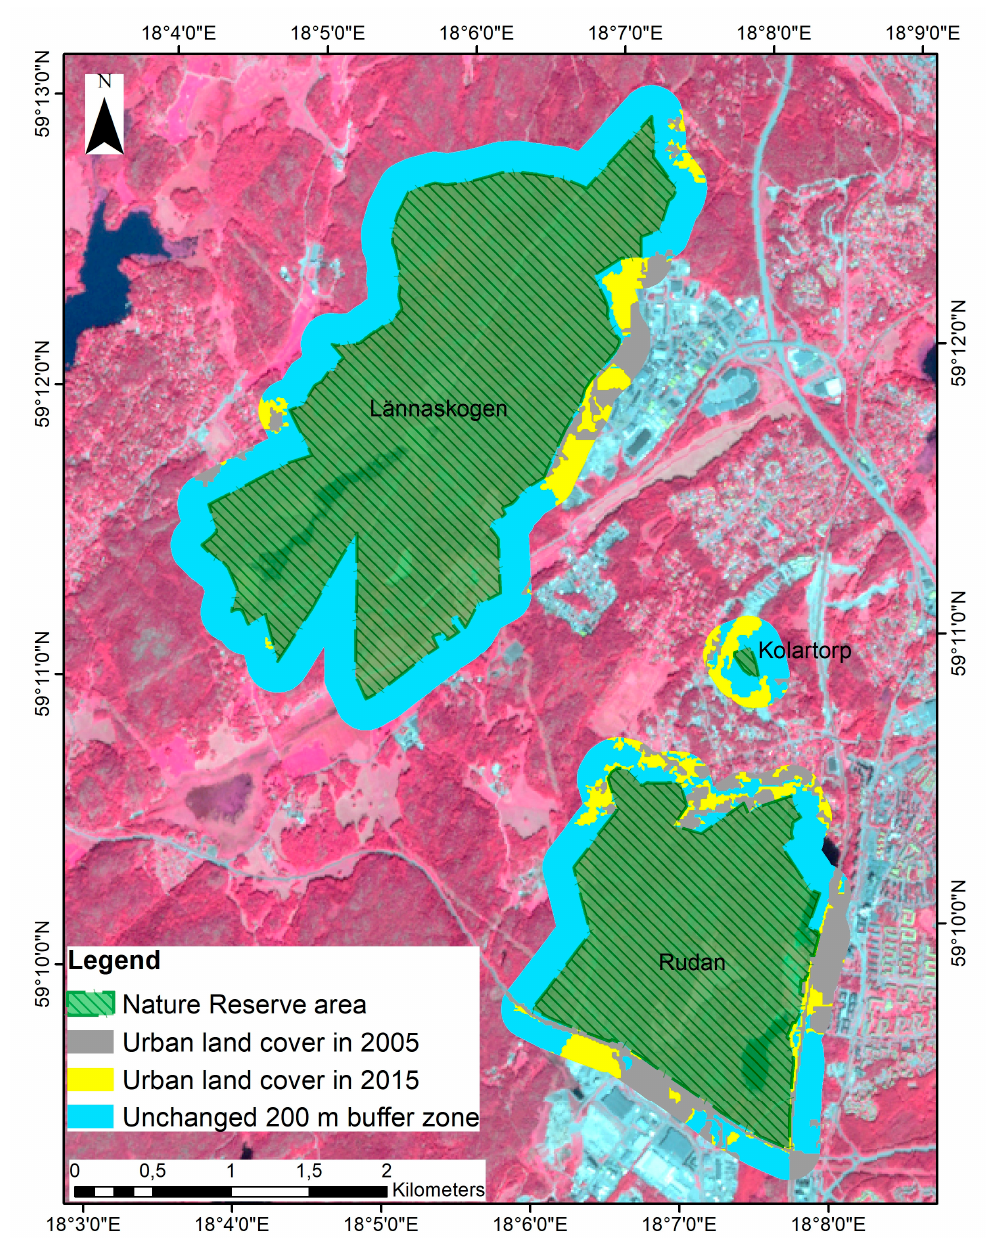
Figure 7. Increase in urban land cover within 200 m of Lännaskogen, Kolartorp and Rudan Nature Reserves in Huddinge and Haninge Municipalities between 2005 and 2015.